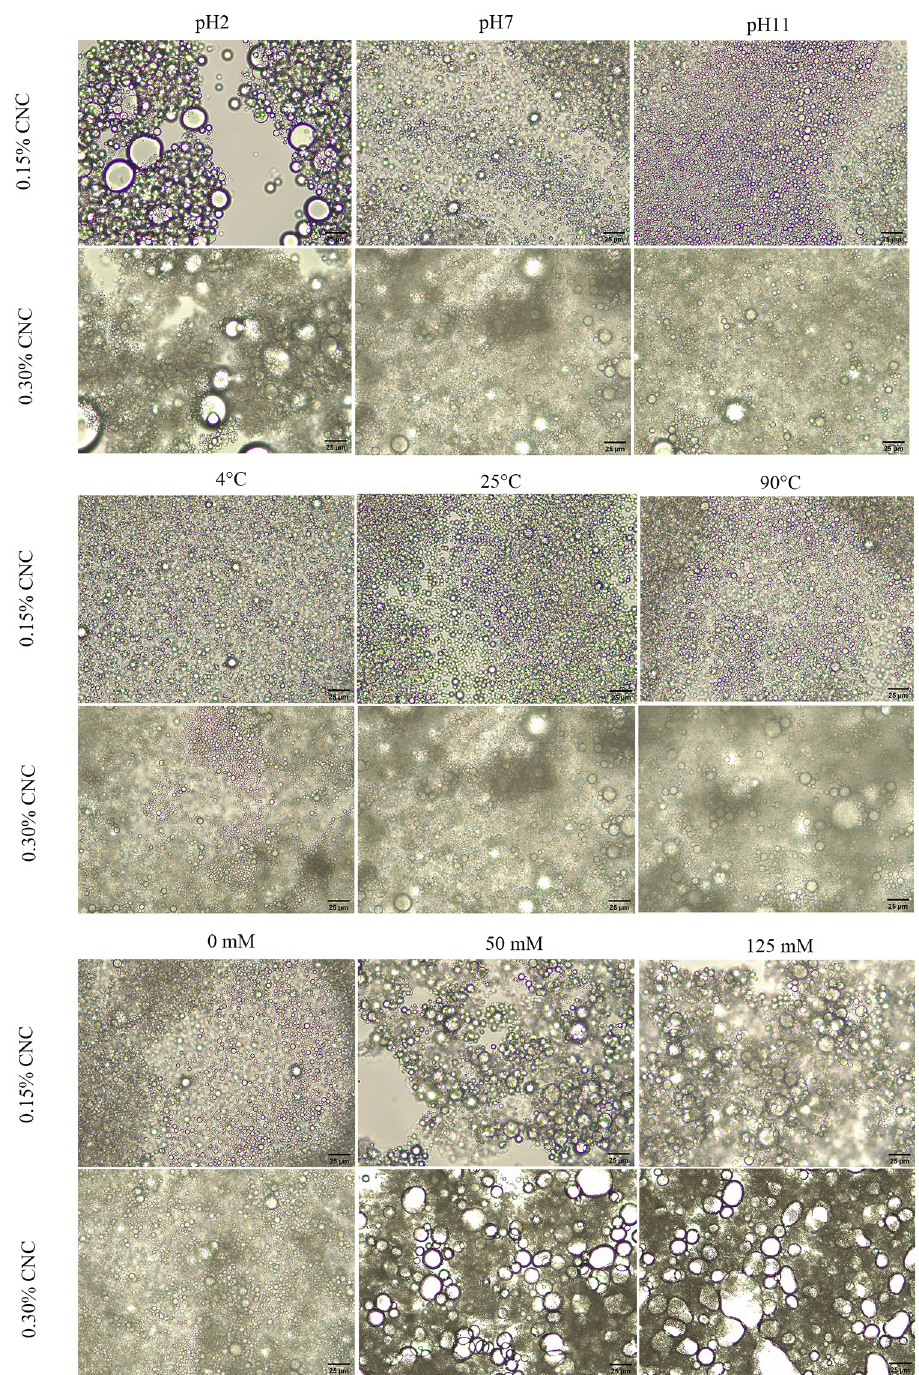
Fig 8. top) Optical micrographs of CNC 0.15 -PE and CNC 0.30 -PE at pH (2, 7, 11); centre) temperature (4˚C, 25˚C and 90˚C); bottom) ionic strength (0mM, 50mM and 124mM) on Day 0 viewed under 40 ×